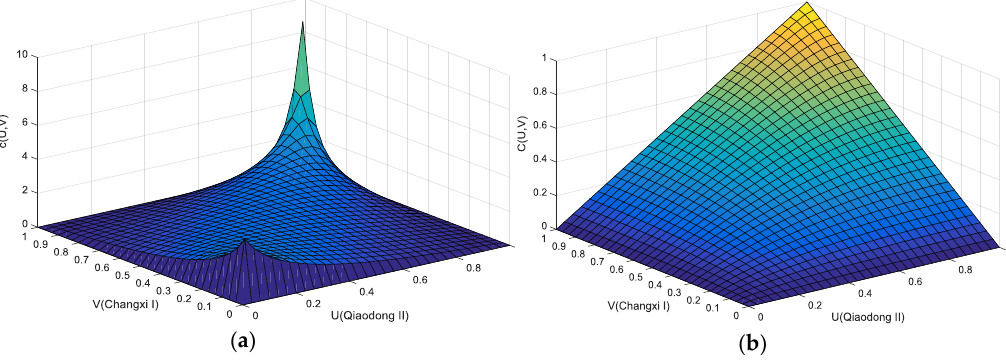
Figure 15. Gumbel-Copula function based on wind speeds of Qiaodong II and Changxi I: ( a ) Gumbel-Copula probability density function; ( b ) Gumbel-Copula cumulative function.